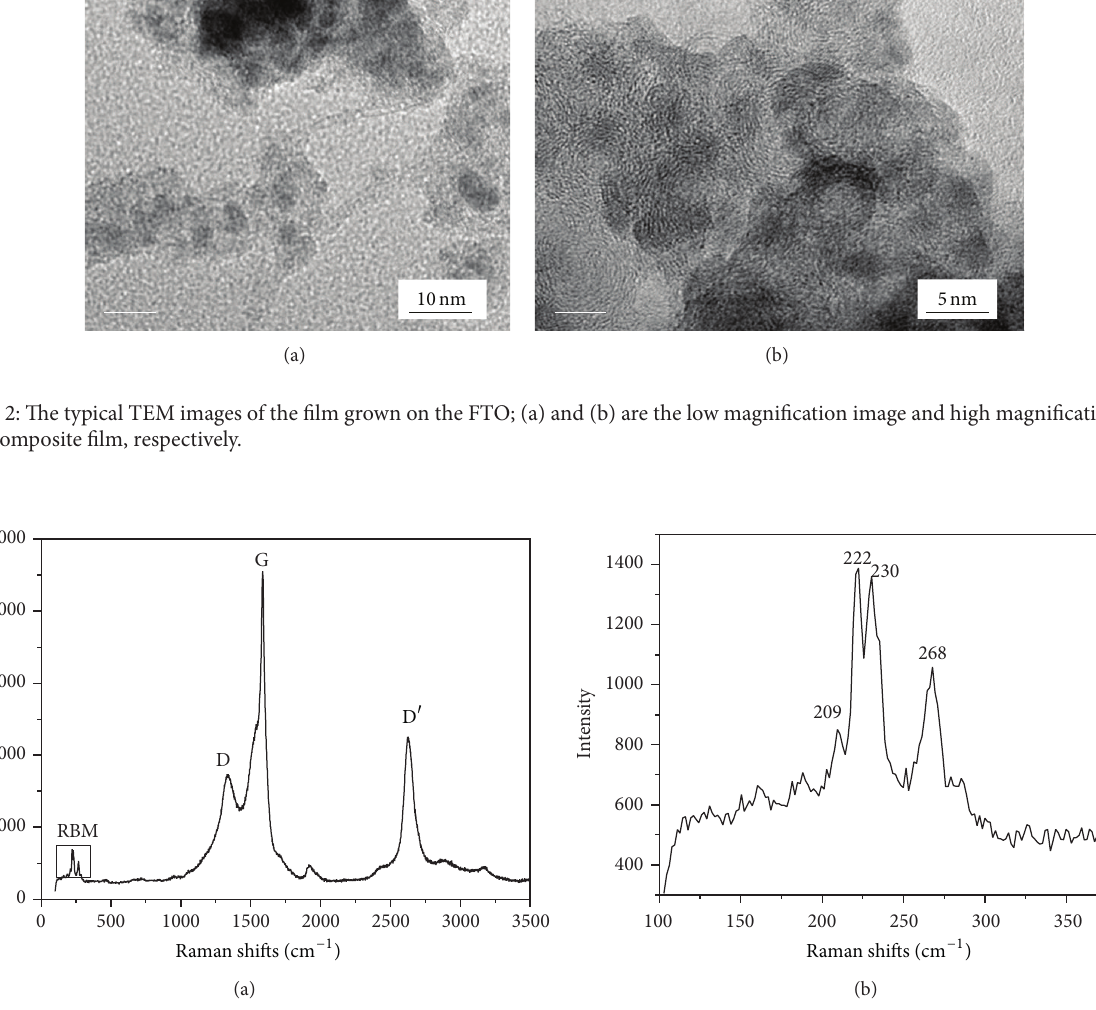
Figure 3: (a) is Raman spectrum of the composite films in Figure 1; (b) is the enlarged of RBM in